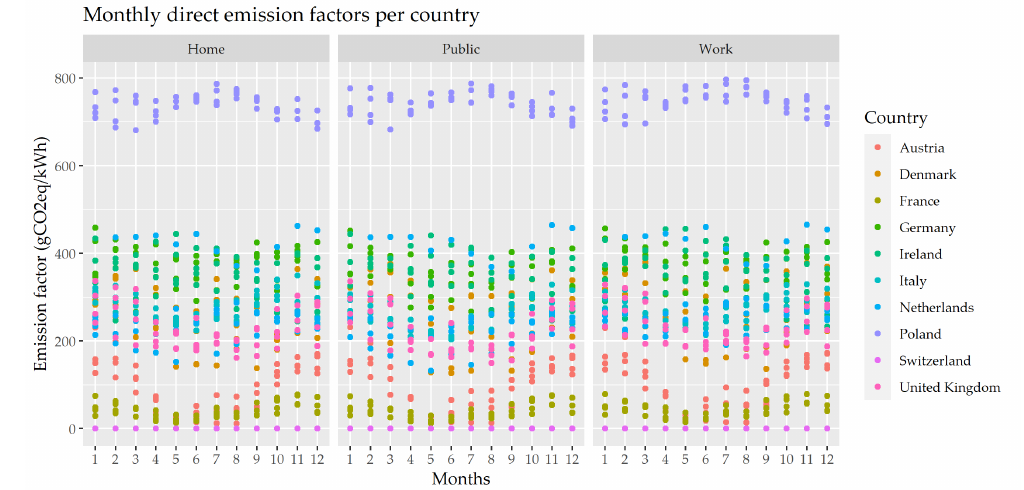
Figure 6. Monthly emission factors of EV charging in each country and each month.